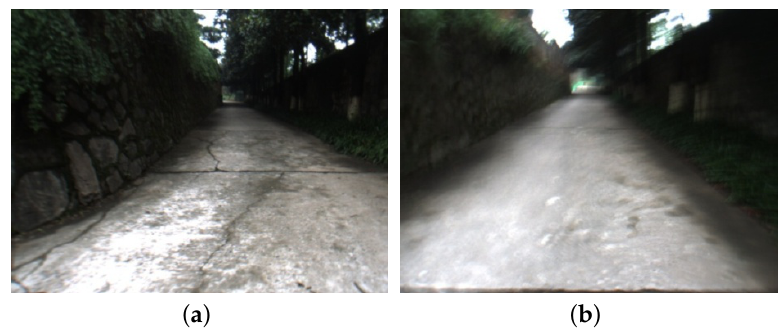
Figure 11. Image samples captured by our platform. ( a ) clear image; ( b ) blurred image.